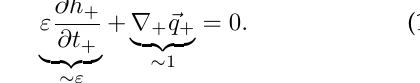
The models discussed so far deal with